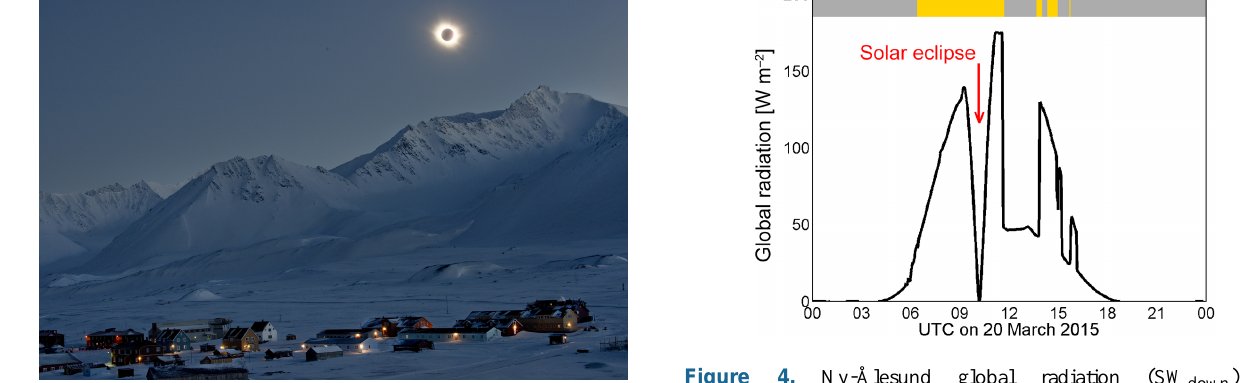
Figure 3. Solar eclipse over Ny-Ålesund, Svalbard. (Photo: Nathalie Grenzhaeuser)